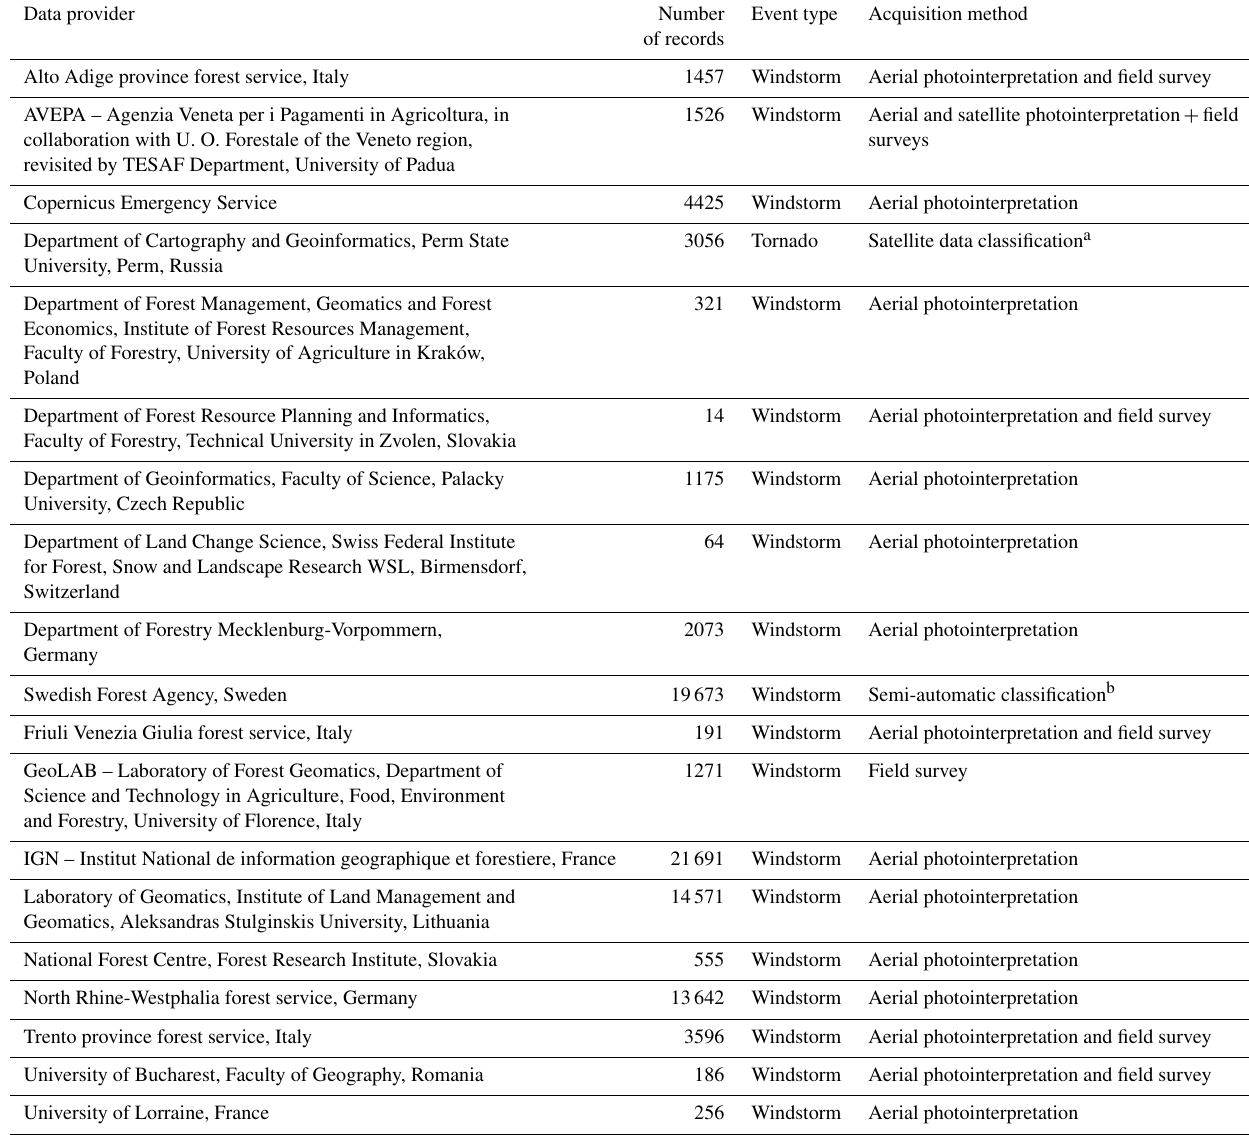
Table 1. List of institutions responsible for wind disturbance mapping and the corresponding number of records collected and acquisition methods